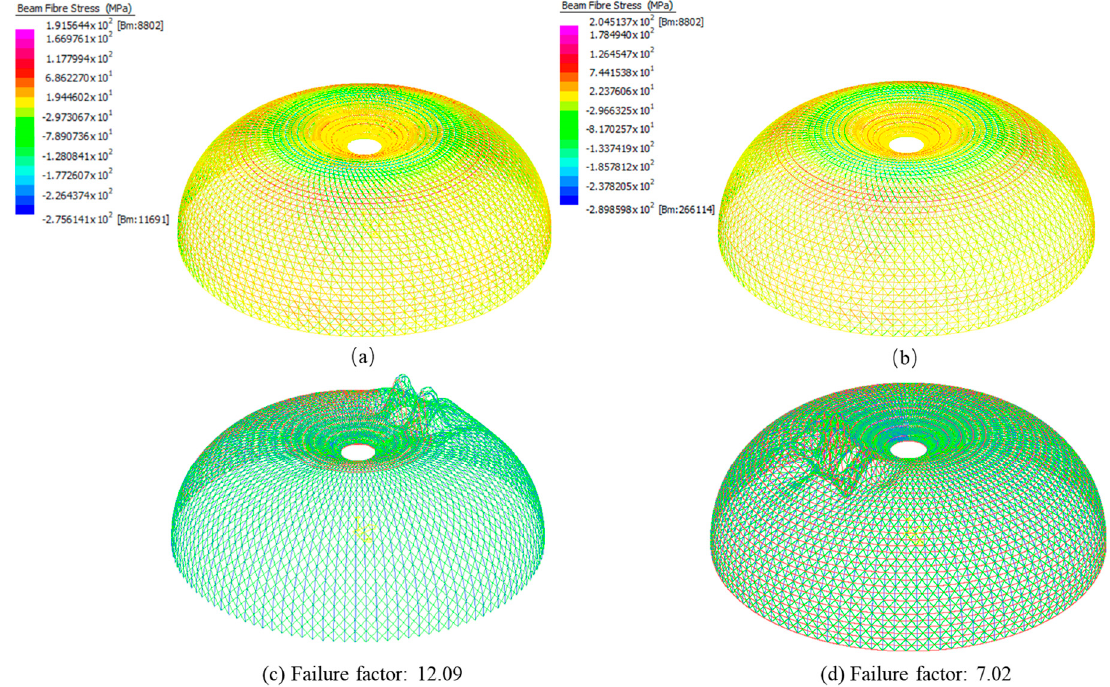
Figure 13. ( a ) Linear analysis of total fiber stress of curved member model under 1.2G + W; ( b ) non-linear analysis of total fiber stress of curved member model under 1.2G + W; ( c ) linear buckling analysis of the straight member model under 1.2G + W; ( d ) linear buckling analysis of the curved member model under 1.2G + W.